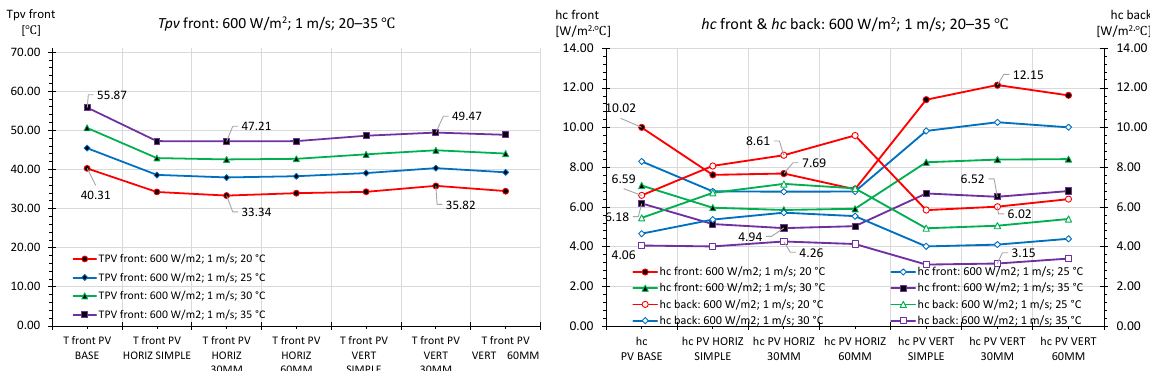
Figure 9. Variation of average operating temperature and convective heat transfer coefficient for studied cases ( G = 800 W/m 2 , v air = 1 m/s and t air = 20–35 °C).